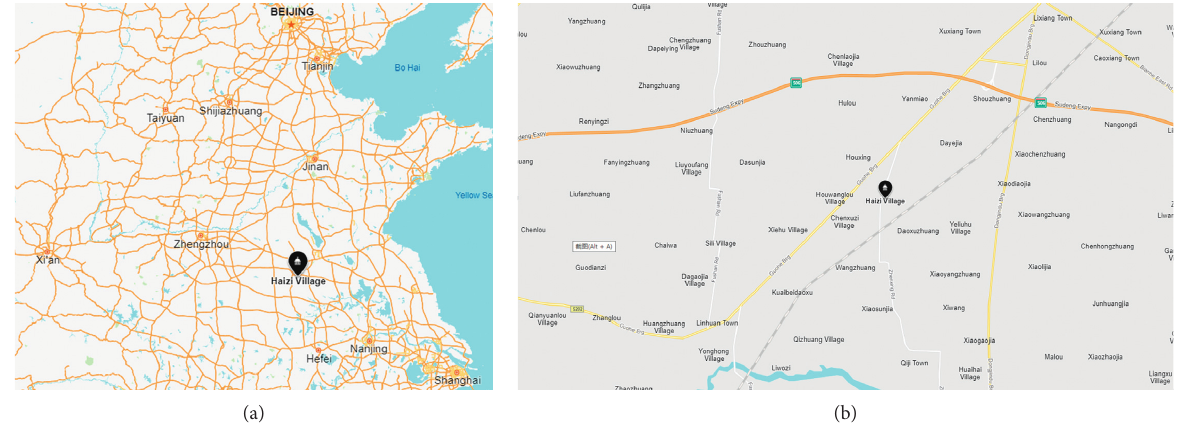
Figure 1: Location of Haizi Coal